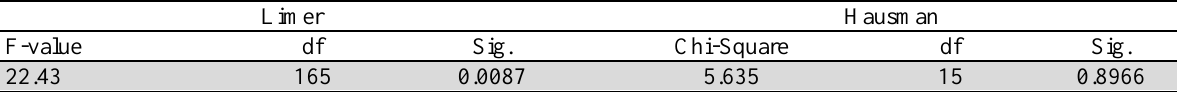
The summary of Limer and Hausman